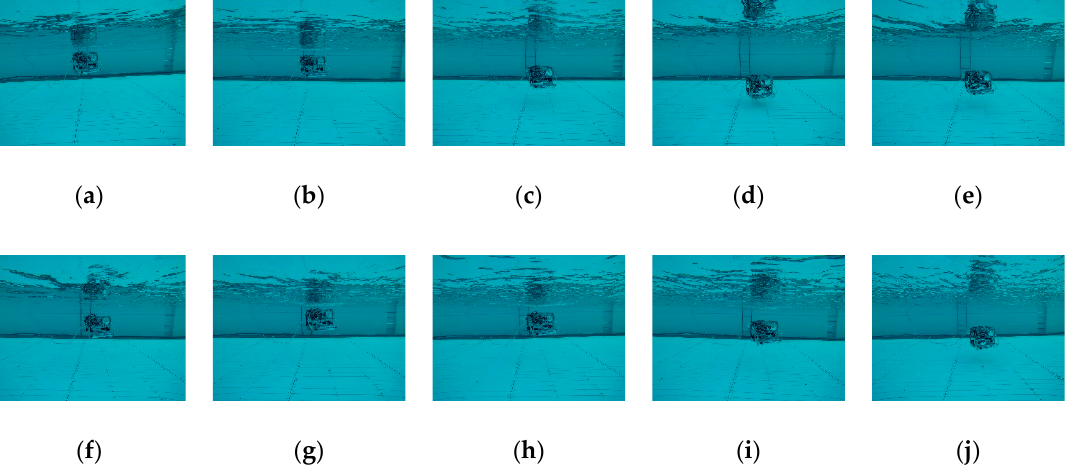
Figure 12. Sine-wave heaving experiment. ( a ) Start diving at the depth of − 0.2 m. ( b ) Dive-down to − 0.4 m. ( c ) Dive-down to − 0.6 m. ( d ) Dive-down to − 0.8 m. ( e ) Float-up to − 0.6 m. ( f ) Float-up to − 0.4m. ( g ) Float-up to − 0.2 m. ( h ) Dive-down to − 3 m. ( i ) Dive-down to − 0.45 m. ( j ) Dive-down to − 0.65 m.